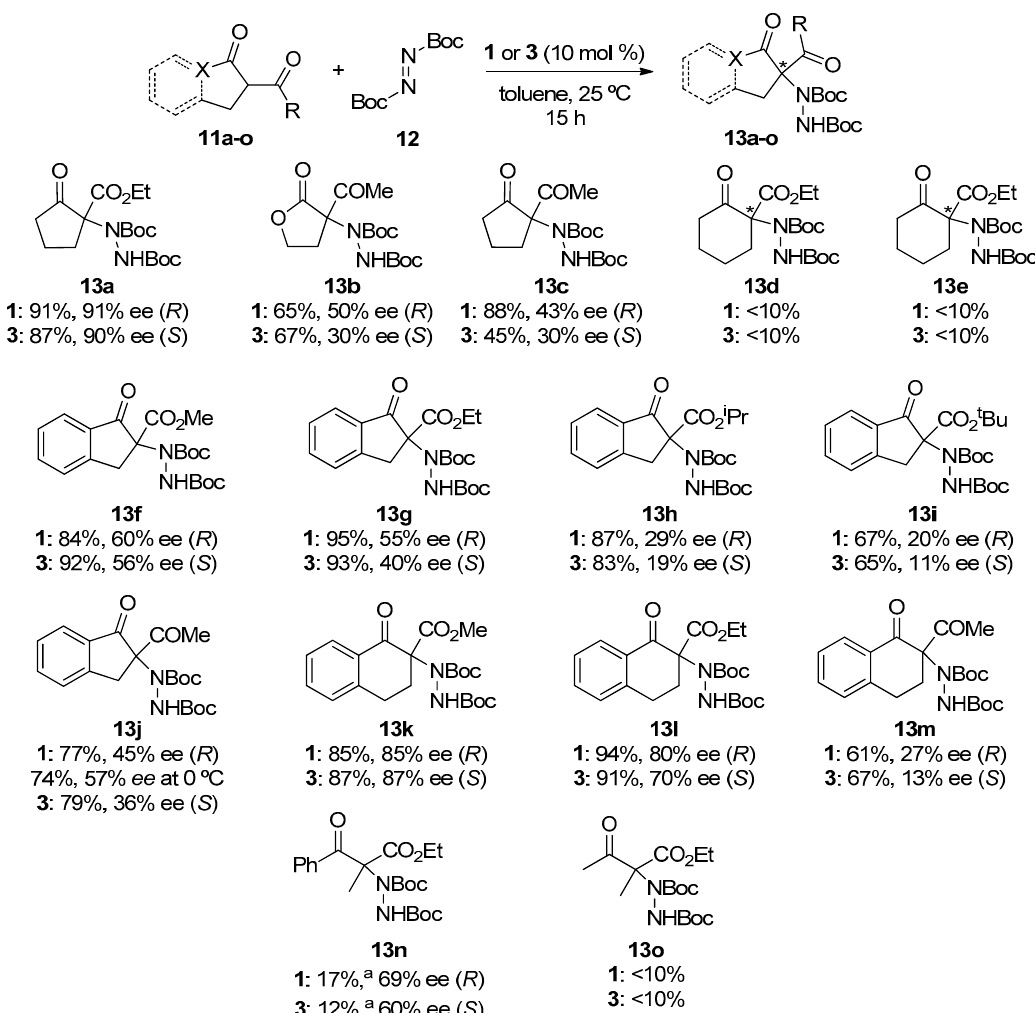
Figure 3. Scope of the reaction.